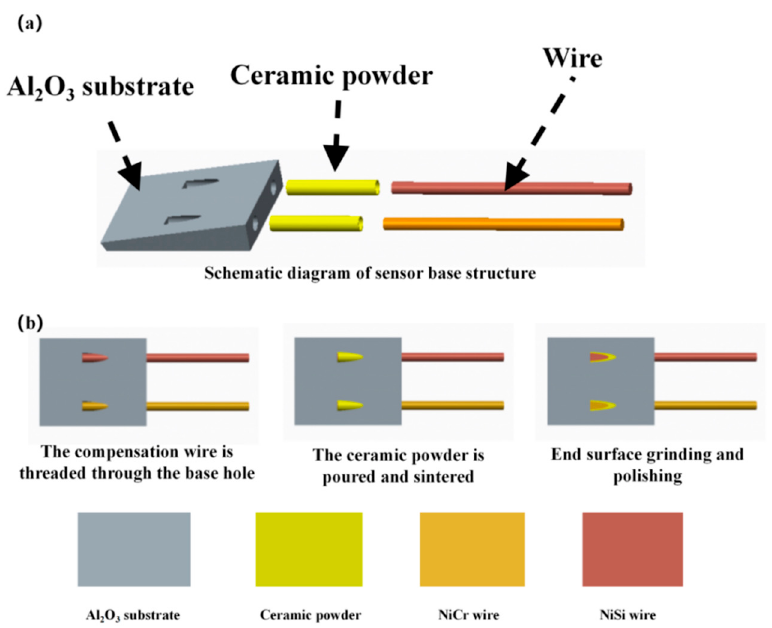
Figure 4. ( a ) Schematic diagram of the sensor substrate structure. ( b ) The integrated wire substrate preparation process.